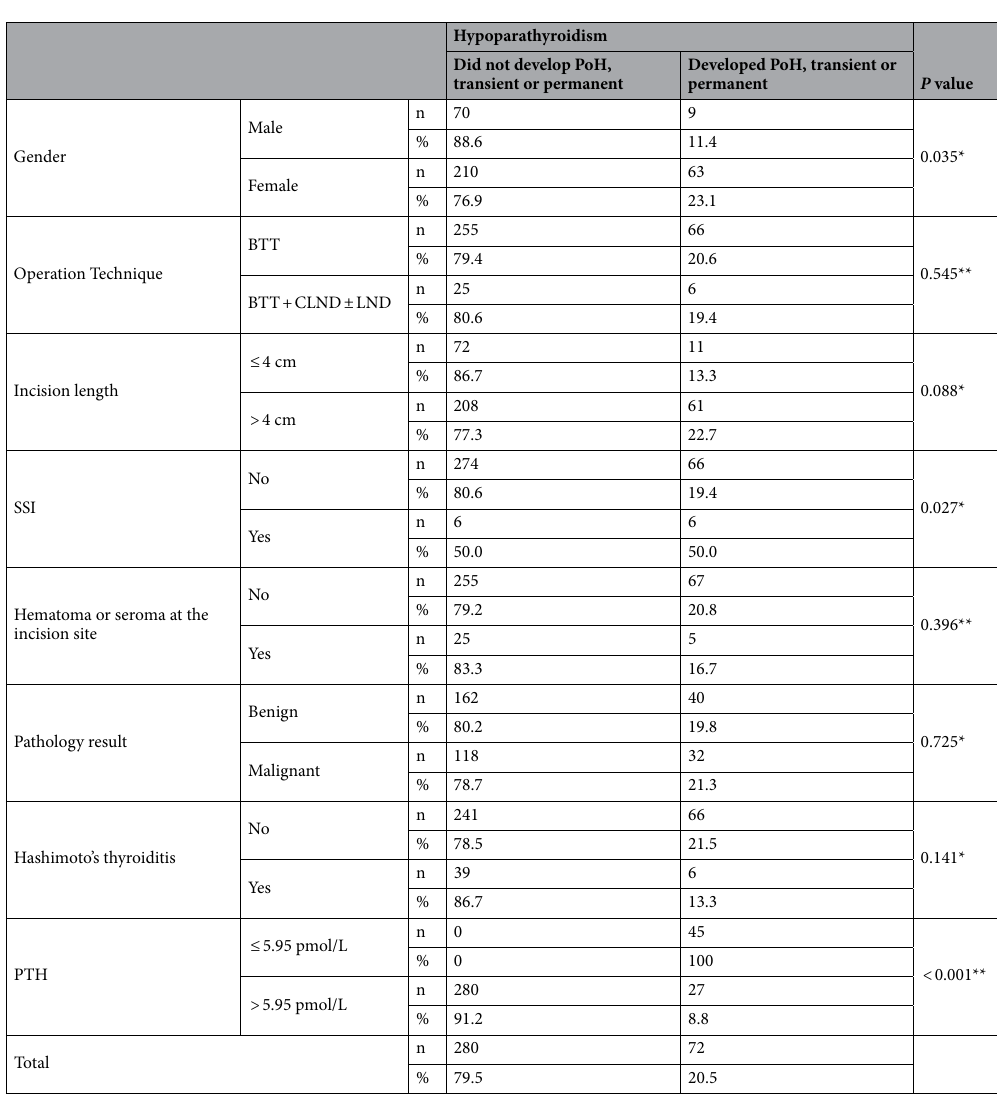
Table 2. Association of some factors with postoperative hypoparathyroidism. n Number, PTH Parathormone, BTT Bilateral total thyroidectomy, CLND central lymph node dissection, LND lateral neck dissection, SSI surgical site infection. *Continuity Correction test. **Fisher’s Exact